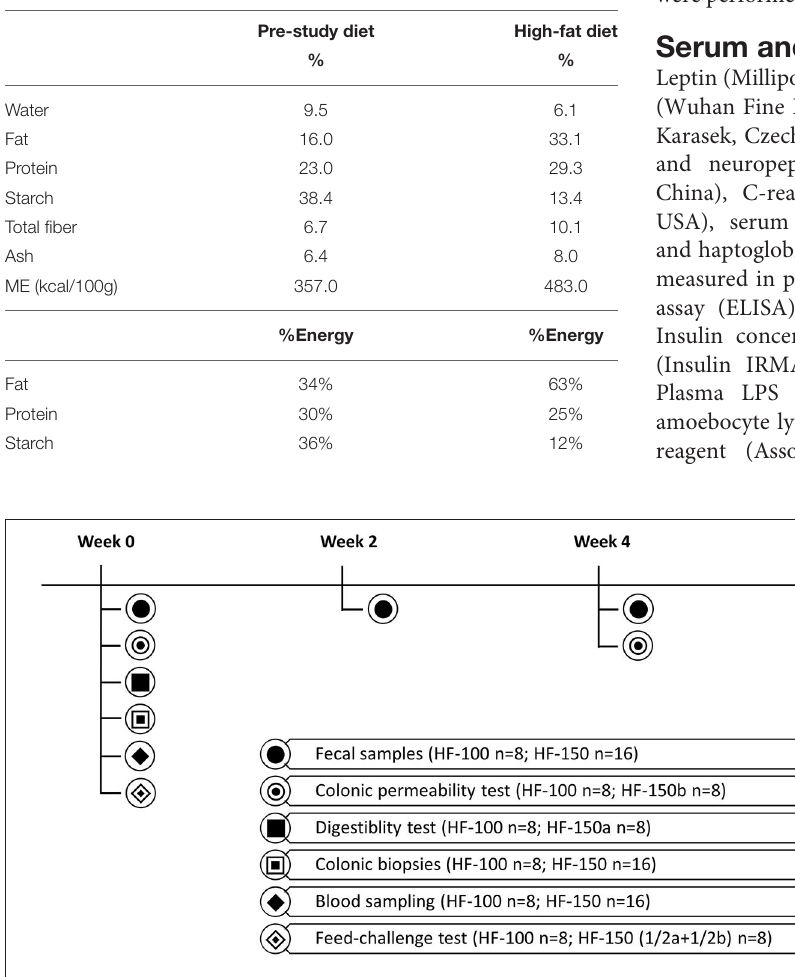
FIGURE 1 | Experimental design of the study. HF-100 corresponds to the group of dogs fed the high-fat diet at 100% of maintenance energy requirement and HF-150 corresponds to the group of dogs fed the high-fat diet at 150% of maintenance energy requirement. HF-150a and HF-150b are two separate subgroups consisting of 8 dogs from the HF-150